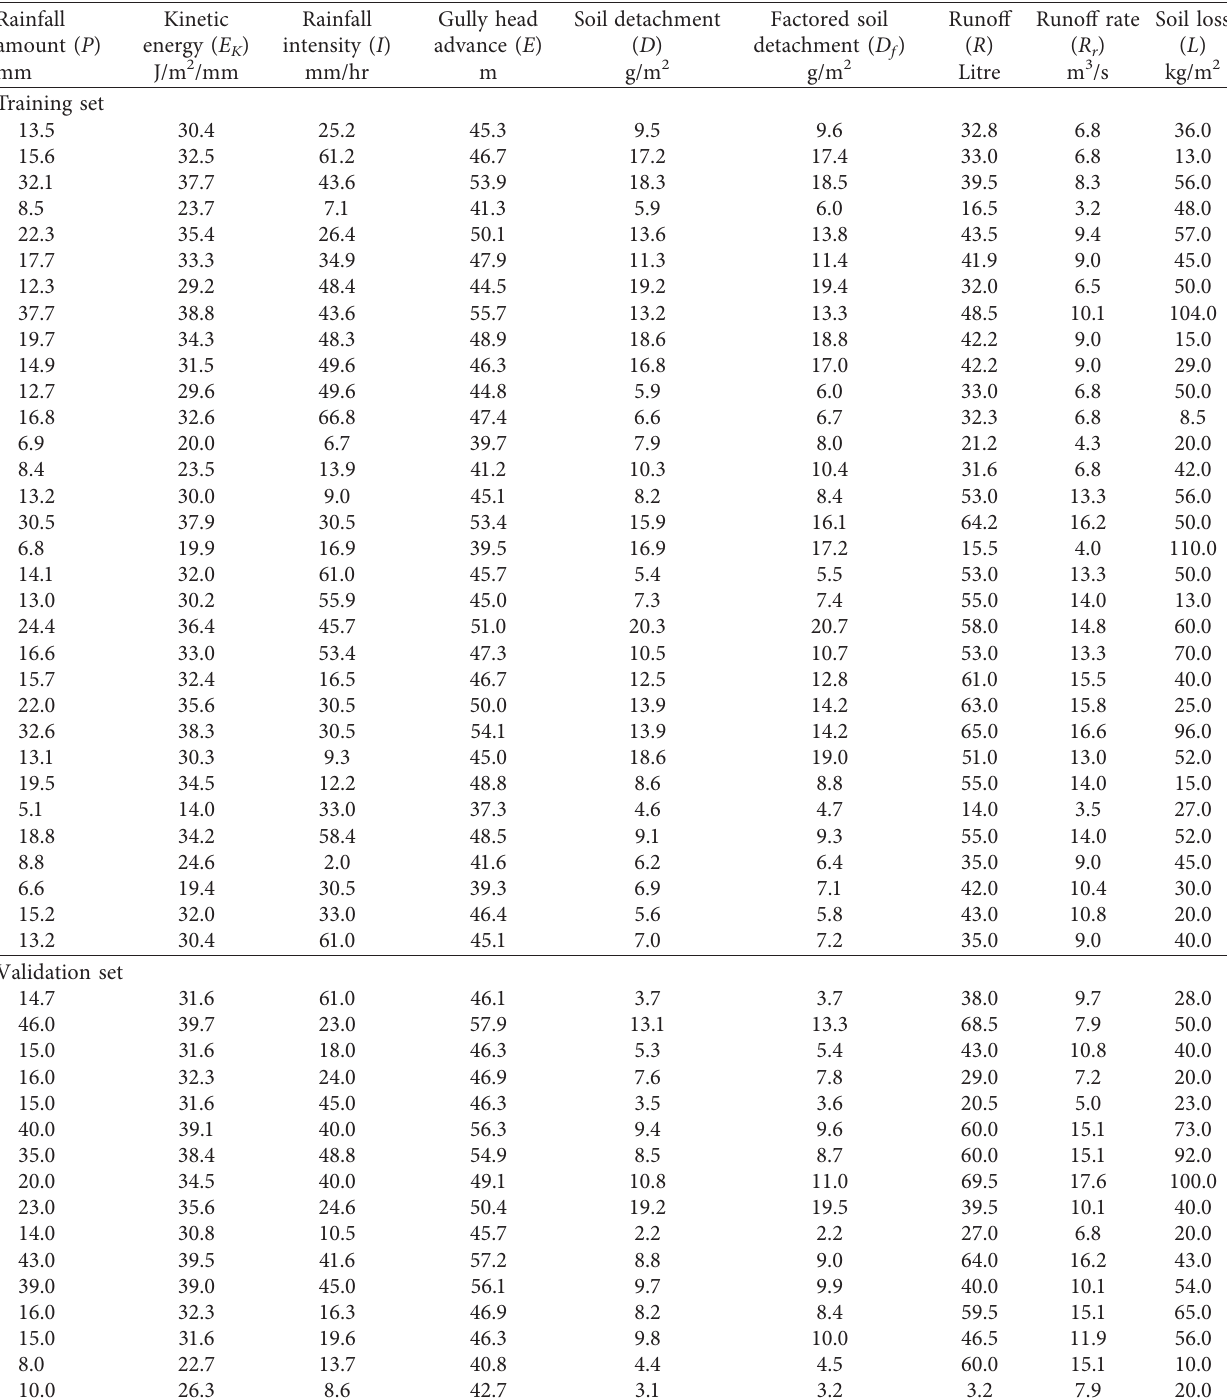
Table 2: Collected